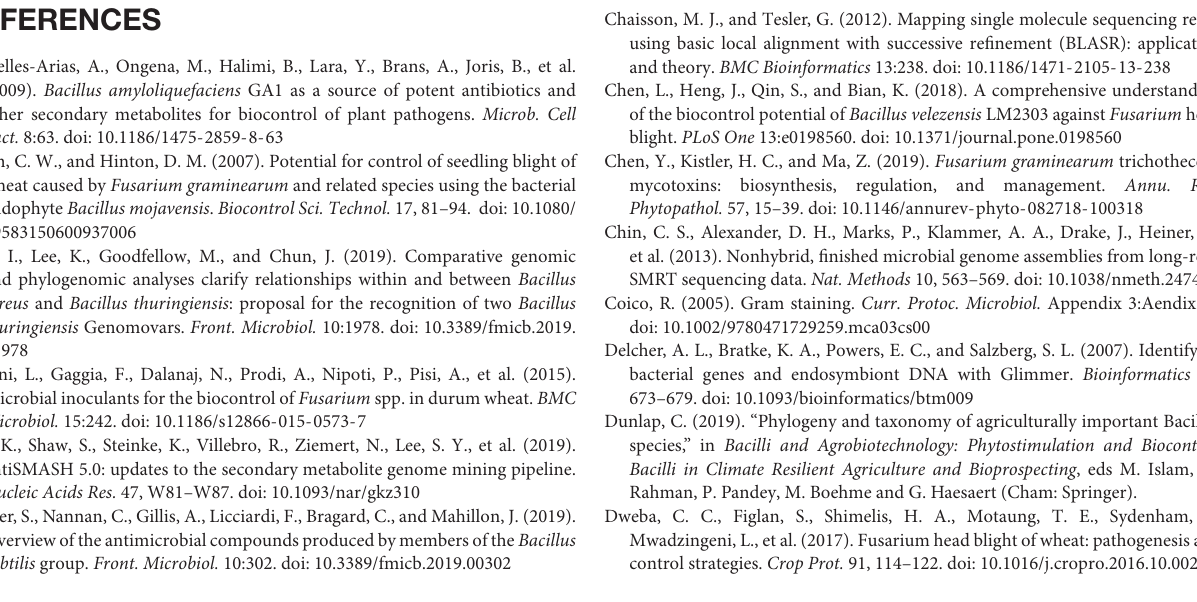
Supplementary Figure 1 | Cell-free extracts of B. velezensis YB-130 inhibit F. graminearum PH-1 in PDA. (A) F. graminearum PH-1 in PDA containing sterile distilled water in the Oxford cup; (B) F. graminearum PH-1 in PDA containing cell-free extracts of B. velezensis YB-130 in the Oxford cup; (C) F. graminearum PH-1 in PDA; (D) F. graminearum PH-1 in PDA containing 10%(v/v) cell-free extracts of B. velezensis YB-130. Supplementary Figure 2 | MALDI-TOF-MS analysis of surfactin produced by B. velezensis